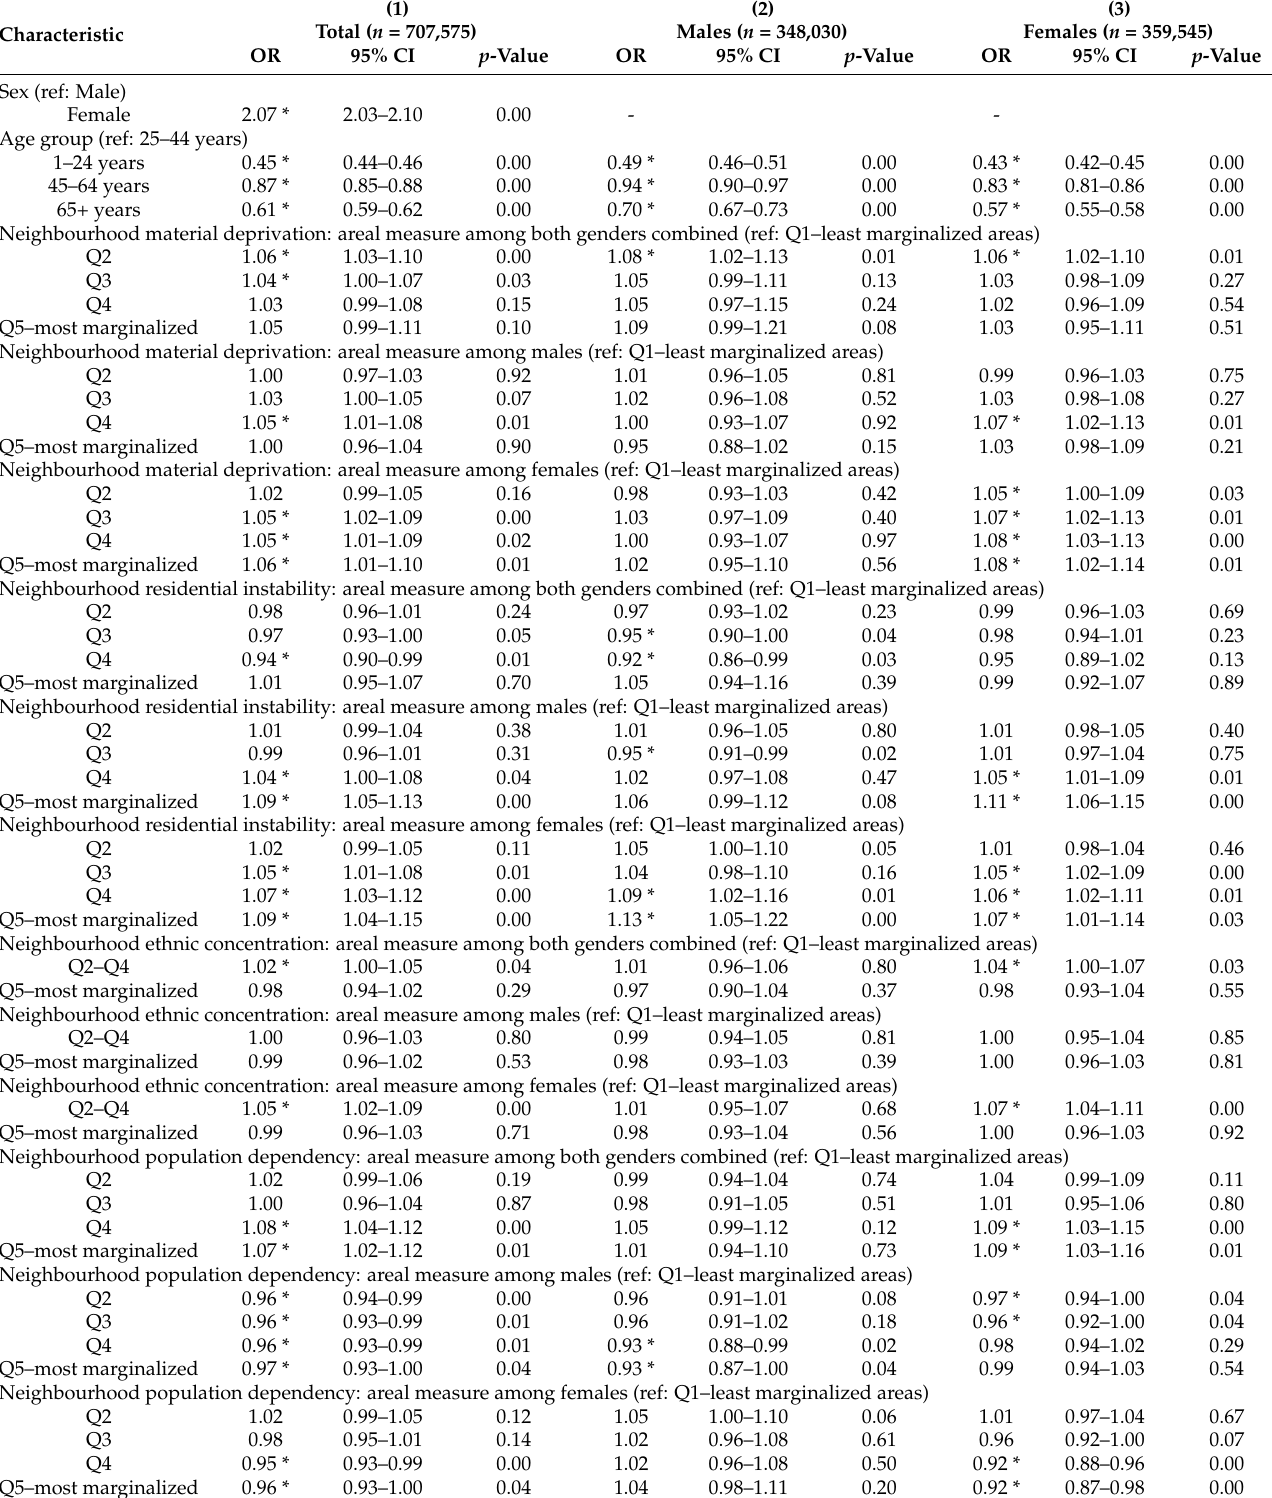
Table 3. Adjusted odds ratios (and 95% confidence intervals) for the risk of healthcare utilization for mood and anxiety disorders—regression models disaggregated by sex at the individual and neighbourhood